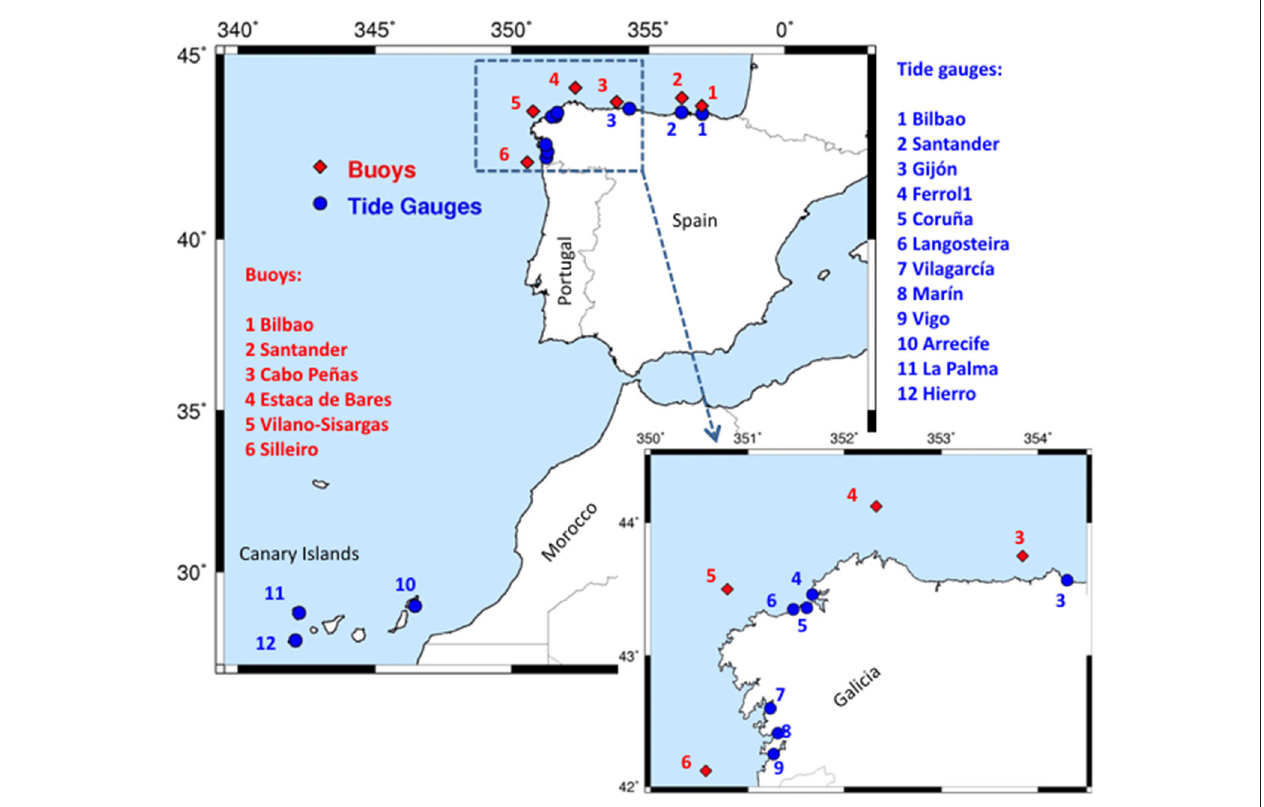
FIGURE 2 | Position of the REDMAR tide gauges and Deep Water buoys from Puertos del Estado. Santander buoy belongs to the Spanish Oceanographic